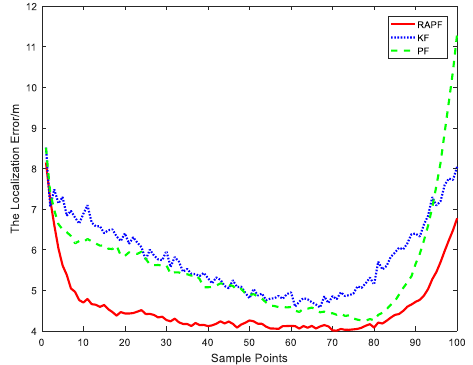
Figure 12. The localization error at each sample points.